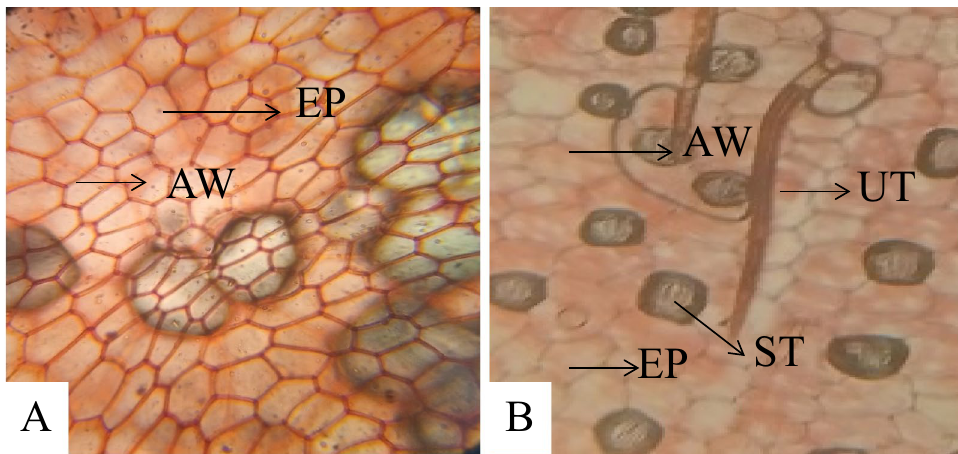
Fig. 2 Surface view of Adaxial epidermis (X400). A Costus afer B Palisota hirsuta AW: Anticlinal wall; ST: stomata; EP: Epidermal cell; UT: Unicellular